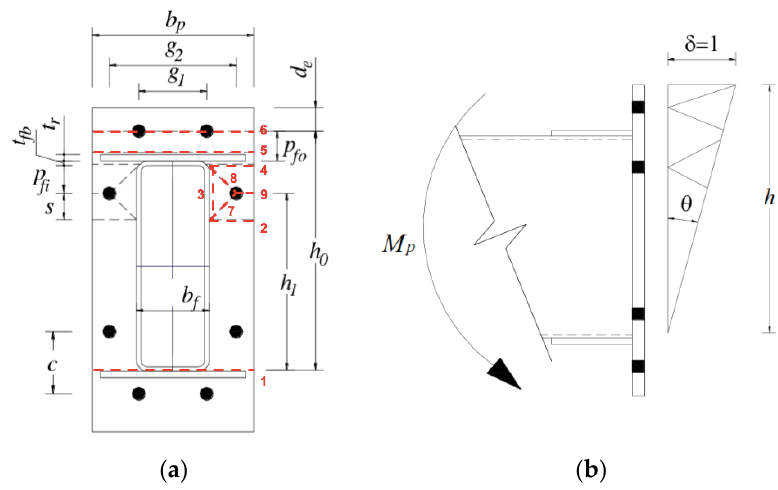
Figure 2. ( a ) View of end-plate yield line mechanisms of HSS moment connection, ( b ) lateral view of connection to calculate the conditions of plastic moment and deformation using the virtual work performed.